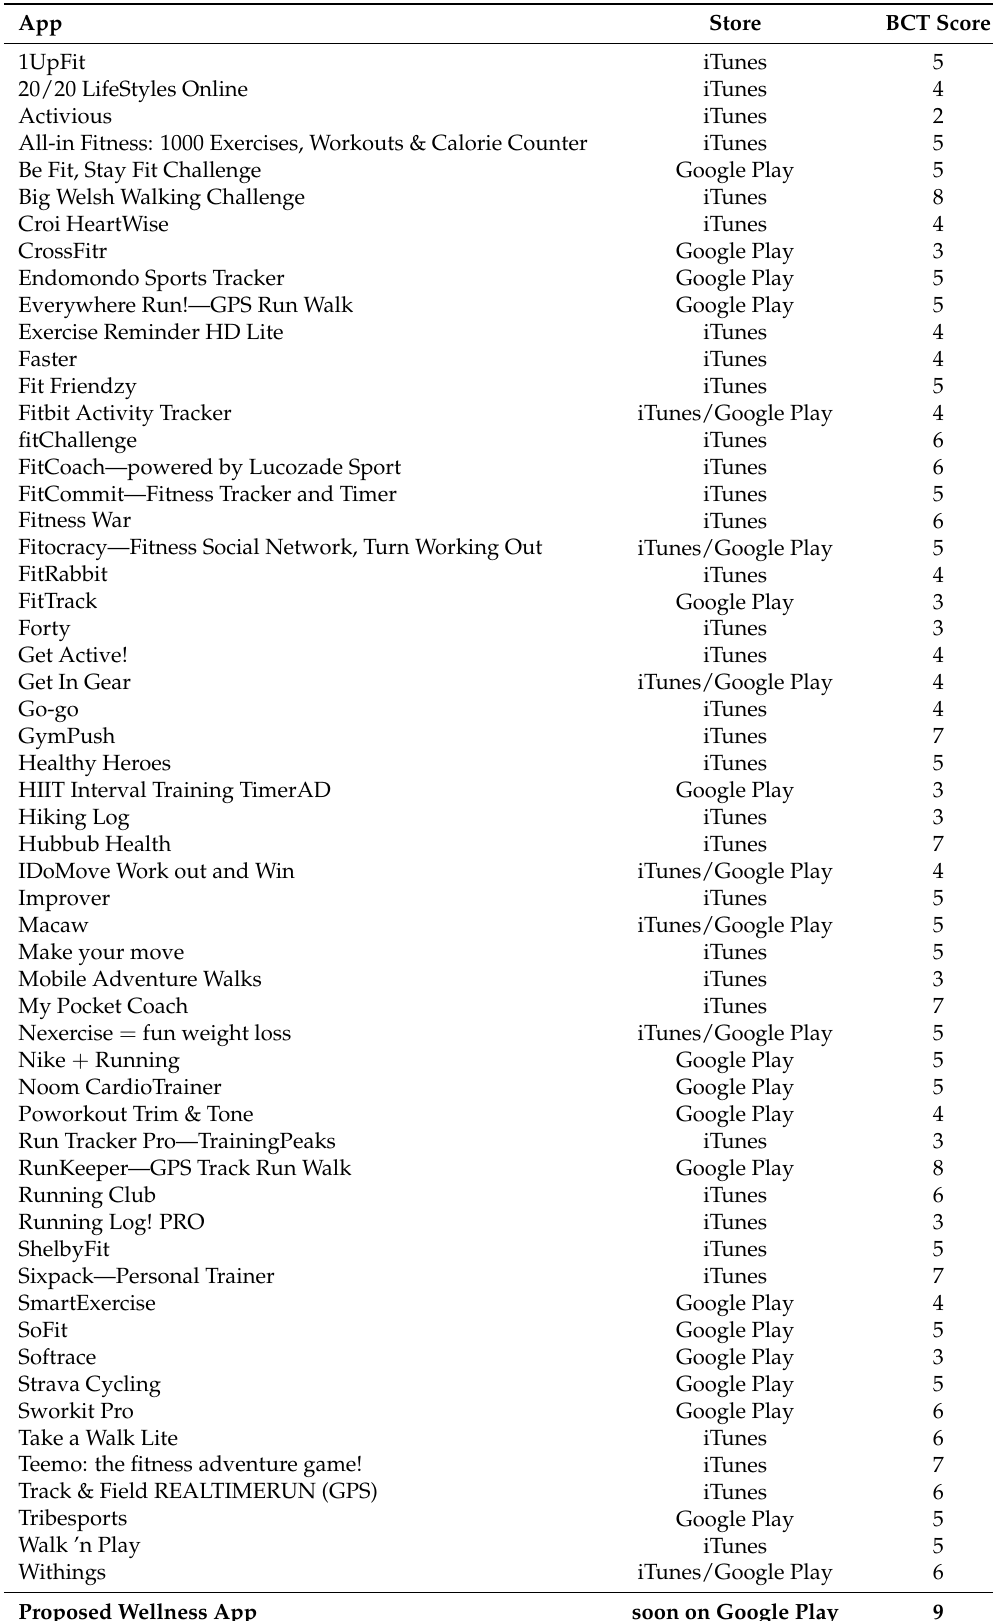
Table 1. Behavior change techniques (BCTs) in Wellness and Health